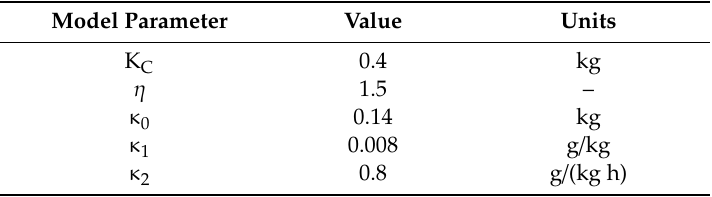
Table 2. Optimized values of the tuning parameters.